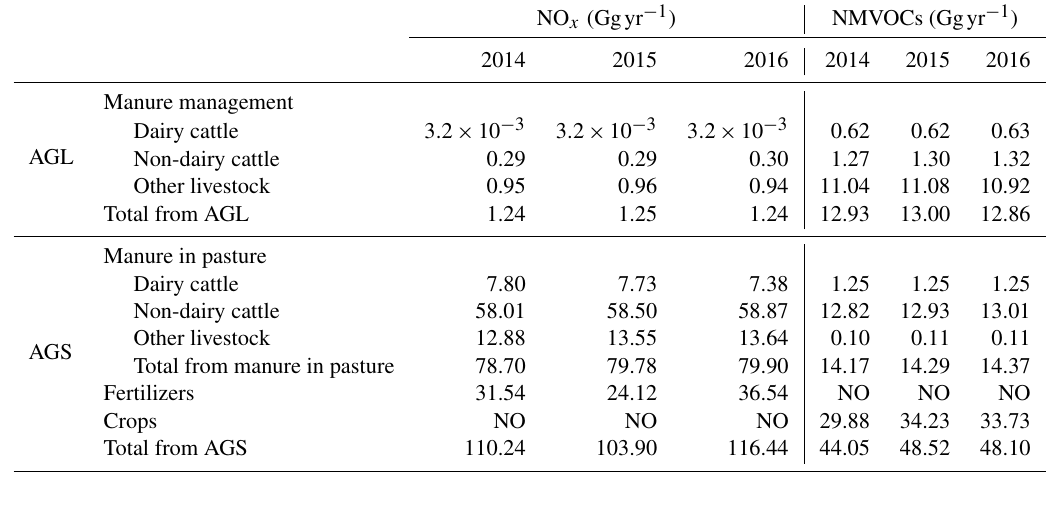
Table A2. Summary of NO x and NMVOC total agricultural emissions by category for the years 2014–2016.